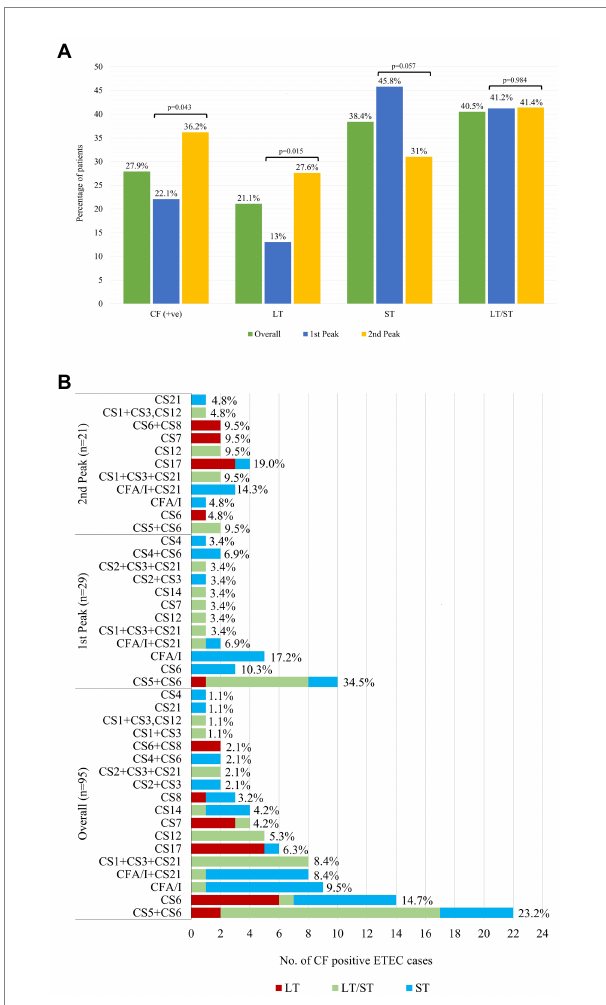
FIGURE 2 Distribution of ETEC enterotoxins (LT, ST, LT/ST) and colonization factors (CFs). (A) Overall Distribution of ETEC enterotoxins (LT, ST, LT/ ST) and colonization factors (CFs) along with the peaks. Comparison of the enterotoxin type (LT, ST and LT/ST) and colonization factors (CFs) isolates between the first and second peak was done using Chi square test at 5% level of significance. (B) Distribution of ETEC Colonization Factors (CFs) as per